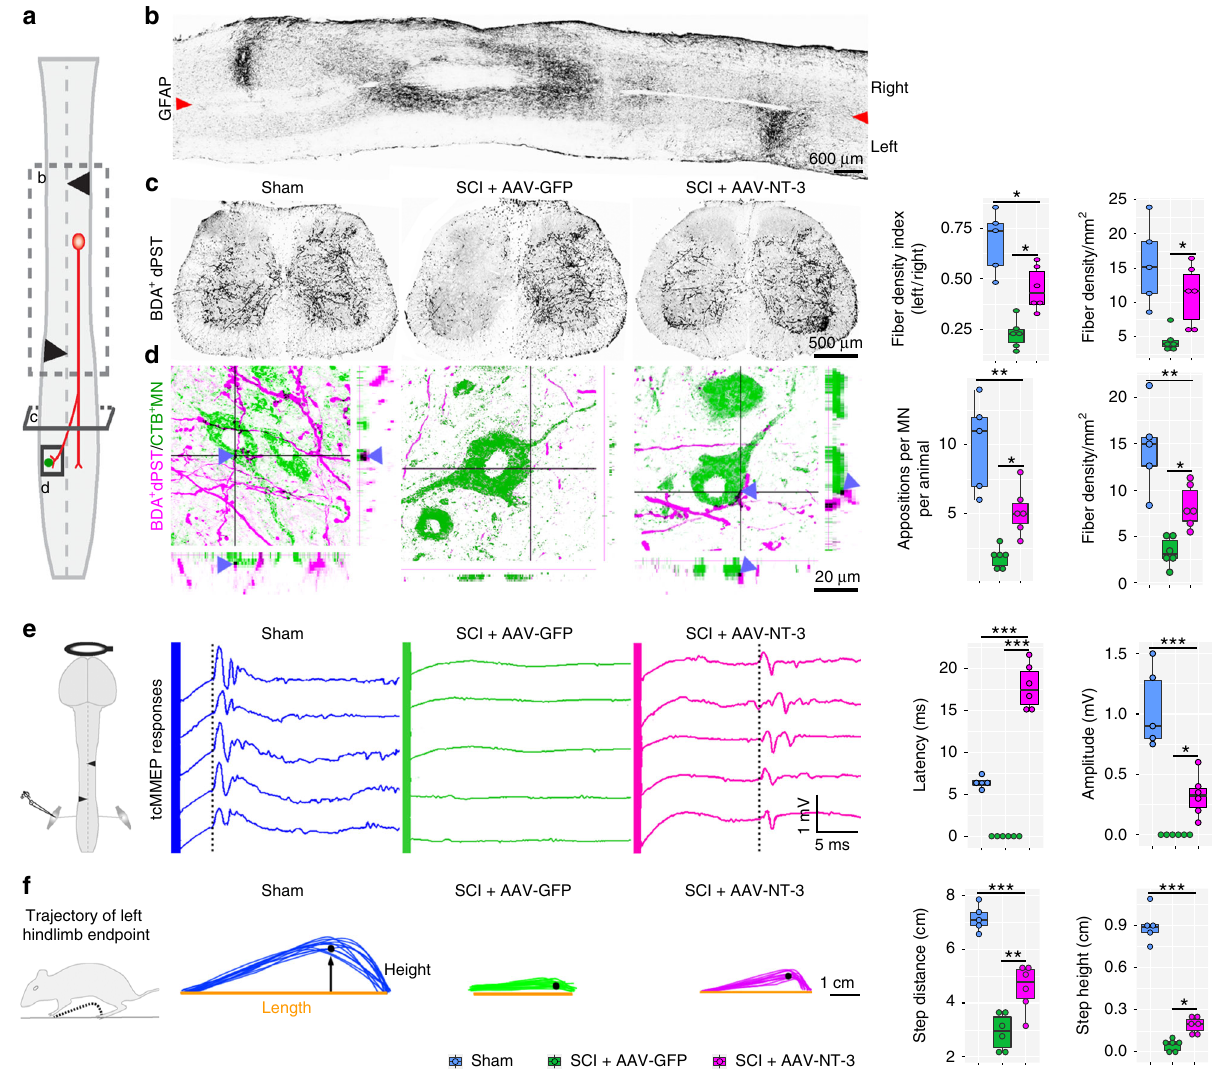
Fig. 5 NT-3 promoted propriospino-MN reorganization after staggered double hemisection. a Schematic shows unilateral injection of BDA (red circle) into the T9 (right) spinal cord in mice with T7 (right) and T12 (left) lateral hemisections. b Representative image shows an anti-GFAP stained horizontal section of the spinal cord after staggered hemisections. Arrowheads indicate the midline. Scale bar = 600 μ m. c Representative images show BDA + dPST axonal distribution in transverse sections of the lumbar spinal cord (L3 – L4) in different experimental groups. Box plots indicate BDA + dPST fi ber density index (left side relative to the right side of the spinal cord) and mean density of dPST fi bers per area of left L3 – L4. Scale bar = 500 μ m. d High magni fi cation images show the BDA + dPST axons innervating CTB-labeled (CTB + ) lumbar MNs (left L3 – L4). Arrowheads indicate the appositions between dPST axons and MNs in a 3D view. Box plots indicate the mean density of dPST fi ber per area and the number of colocalized puncta in the left ventral horn of L3 – L4. Scale bar = 20 μ m. e Schematic shows the tcMMEP response recorded from left gastrocnemius muscle, were evoked by a magnetic fi eld applied to the motor cortex. Representative tcMMEP signals are plotted among three groups at 6 weeks after the staggered lesions. The plots report the average latency and peak-to-peak amplitude of tcMMEPs among three groups. f Schematic and representative stacked traces show the trajectory of left hindlimb endpoints between groups at 6 weeks after staggered lesions. Box plots indicate average step lengths and heights between groups. Data are presented as box plots with center lines indicating medians, boxes representing 25th to 75th percentiles, and whiskers representing data points within 1.5 times the IQR; n = 5 – 6 biologically independent animals per group; * P < 0.05; ** P < 0.01; *** P < 0.001. One-way ANOVA followed by Tukey ’ s post-hoc test. tcMMEPs transcranial magnetic motor-evoked potentials, CTB cholera toxin subunit B. Source data are provided as a Source Data fi